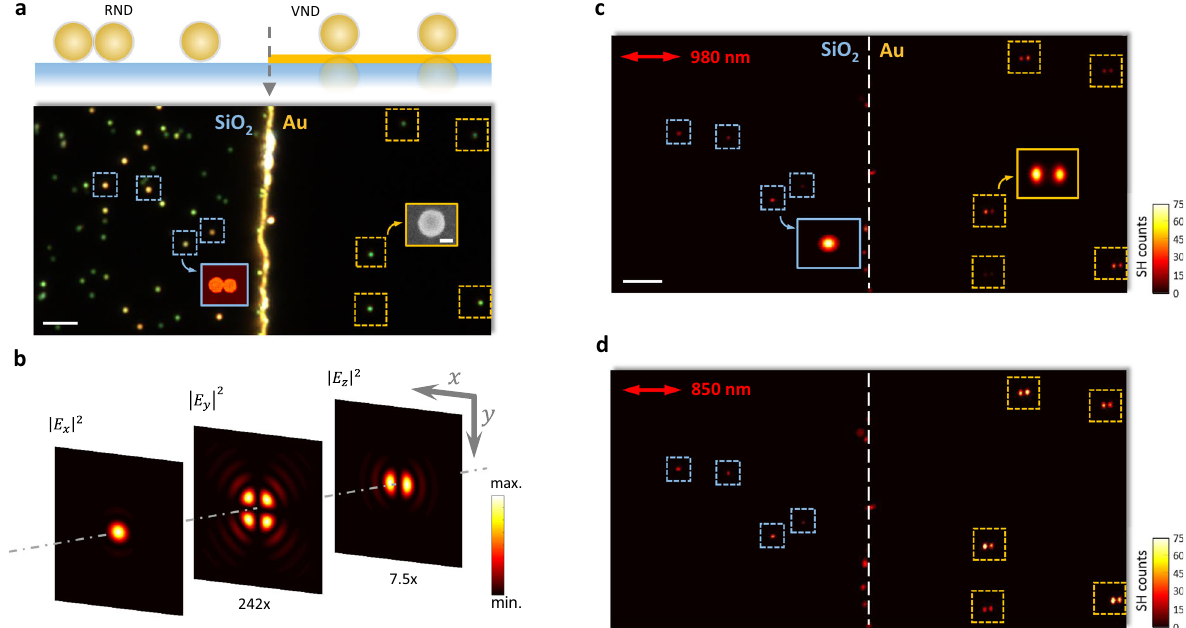
Fig. 3 SHG confocal mapping for RND and VND nanostructures. a Dark- fi eld image of two separate areas containing gold nanospheres dispersed on silica and gold fi lms, respectively. On a silica substrate, the bright yellow spots correspond to the RND structures (with δ typically ranging from 1.0 to 1.26 as con fi rmed by the AFM imaging), while the green spots correspond to gold nanosphere monomers. On a gold substrate, 5 VNDs appear as green spots. Inset shows the SEM micrograph of a single VND. The scale bar is 50 nm. b Calculated intensity distributions for the three fi eld components of a highly focused laser beam at the focal plane of a 100× objective (numerical aperture 0.95). The incident beam is polarized along the x direction and has a wavelength of 850 nm, corresponding to the SHG experimental conditions. c , d SHG confocal images of RNDs (left) and VNDs (right) under off- (( c ), 980 nm) and on-resonance (( d ), 850 nm) fs-laser excitation. The time duration of the laser beam dwelling at each pixel is 18 μ s. The double-headed red arrows indicate the polarization direction of the fundamental light. Insets in ( c ) show the images for the RNDs and VNDs scanned with higher resolution and longer pixel dwelling time (72 μ s). The color bars indicate the SH intensity in photon counts per μ s. Only several RNDs are visible in the SHG images with the axes oriented along with the fundamental light polarization (see Supplementary Note 5). Scale bar in ( a ), ( c ) is 5 μ